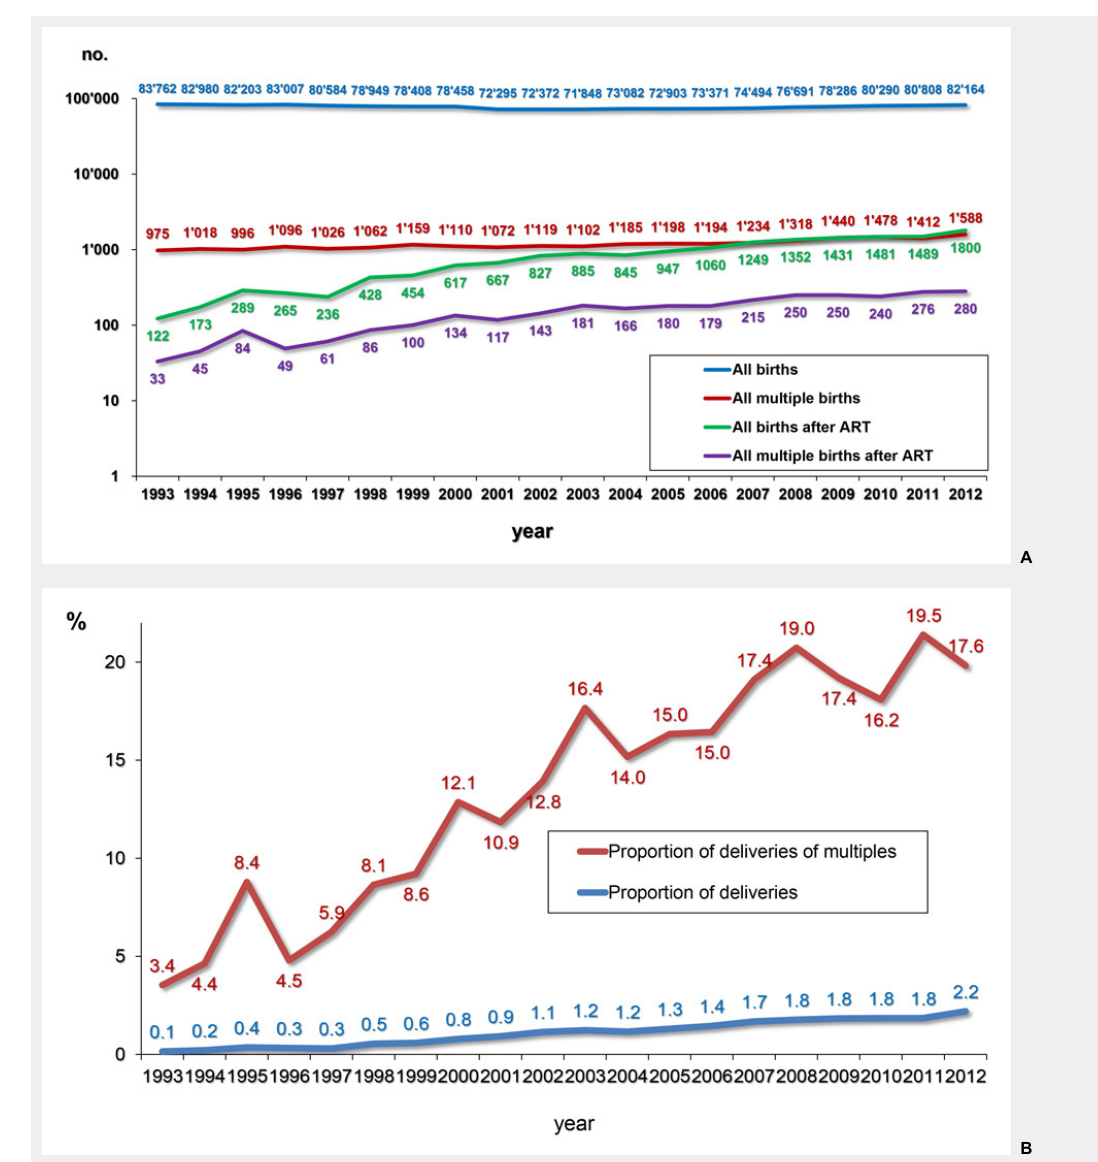
A By putting together the number of all deliveries and the overall number of multiple deliveries (given by the BfS) and the number of deliveries and multiple deliveries after ART (recorded by FIVNAT-CH), the number of births and multiple births generated by ART can be compared with the overall birth data in Switzerland. Since 1993 both the absolute number of births generated by ART and the absolute number of multiple deliveries, mostly of twins, have been rising continuously. B Since 1993, the proportion of births generated by ART has been rising almost continuously, so that in 2012 2.2% of all deliveries in Switzerland were originated by ART. In addition, the proportion of multiple deliveries generated by ART has risen to 17.6% of all multiple births in Switzerland in